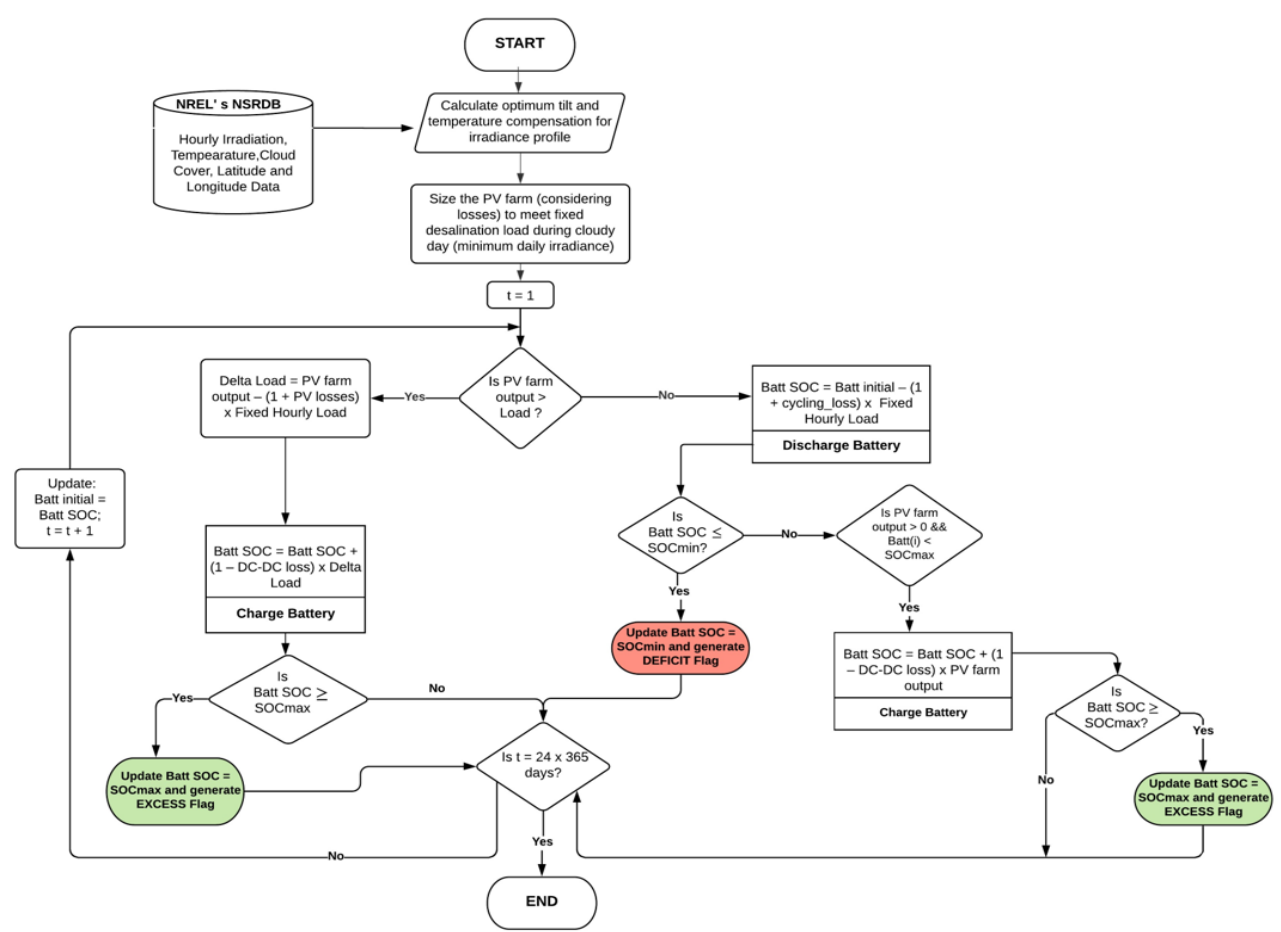
Figure 10. Flowchart for desalination system operation. In this figure, NREL and NSRDB represent National Renewable Energy Laboratory and National Solar Radiation Database respectively.